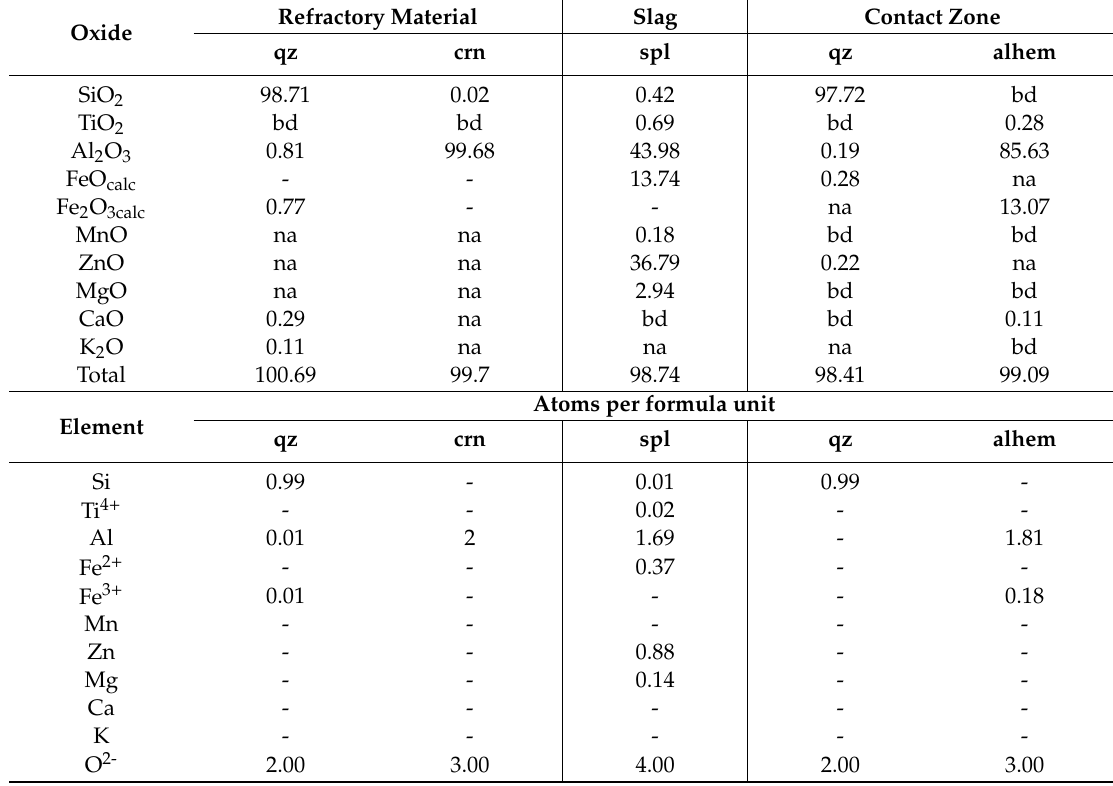
Table 3. Representative EPMA data of the